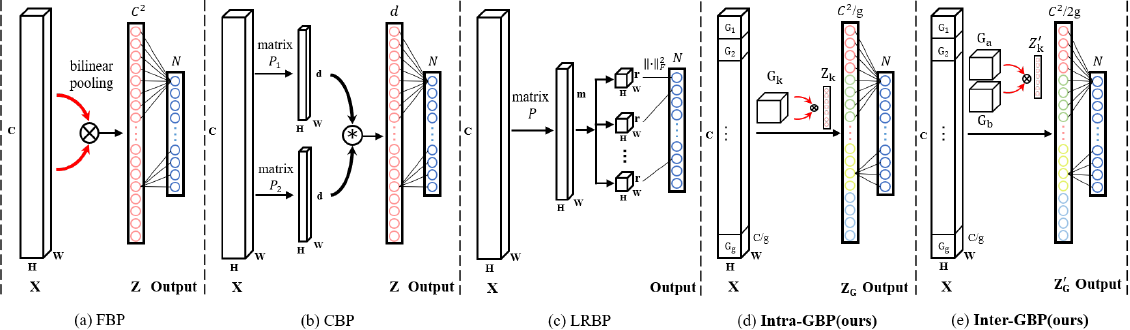
Figure 2. ( a ) Full bilinear pooling (FBP), bilinear pooling is performed in pairs in all feature layers. ( b ) Compact bilinear pooling (CBP), the feature layer is mapped and the Hadamard product is used to simplify bilinear pooling. ( c ) Low-rank bilinear pooling (LRBP), which obtains statistics without performing bilinear pooling, instead using the Frobenius norm as the classification score. ( d ) The intra-group bilinear pooling (Intra-GBP), bilinear pooling performs in each grouped feature layer group. ( e ) The inter-group bilinear pooling (Inter-GBP), bilinear pooling performs between two different grouped feature layer